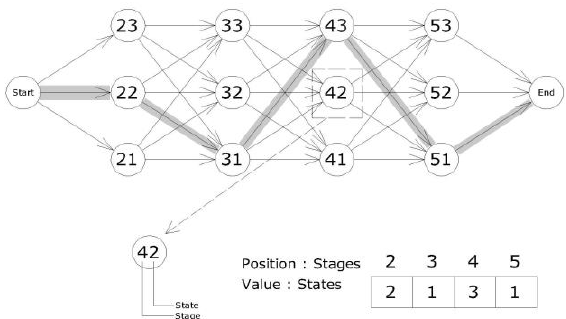
Fig. 1. Flow network for a simple MPP